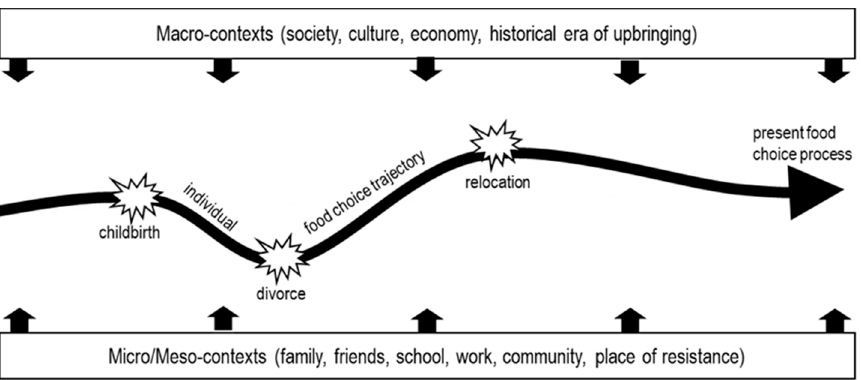
Figure 2. A conceptual model of the life course perspective on sustainable food choice. Adapted from Devine et al. (1998) [54]; Sobal et al. (2006)